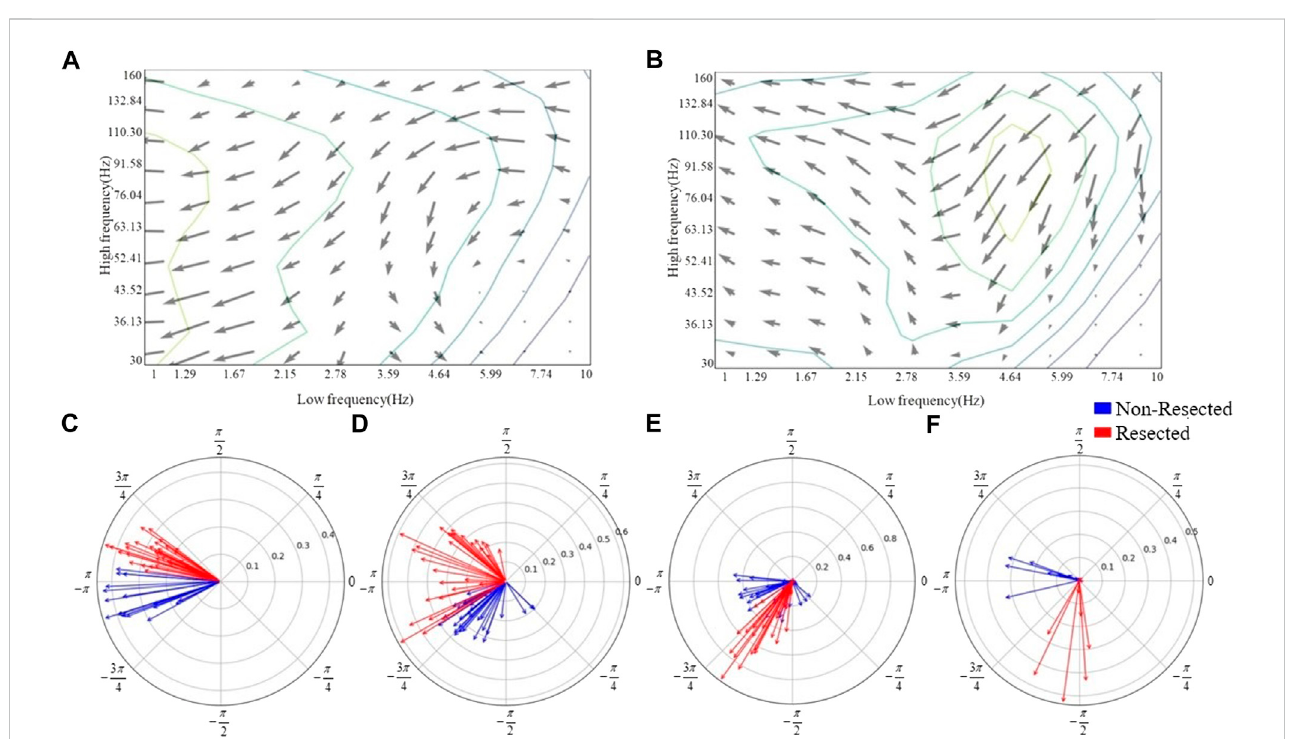
FIGURE 4 Phasedistributionoflow-frequencybands. (A) ThequivermapofaveragedstrengthandphaseofCV-PACsinnon-resectedregions.Notethatthelength and angle of each gray arrow represent the coupling strength and coupled phase at each high- and low-frequency pair, respectively. (B) The quiver map of averaged strength and phase of CV-PACs in resected regions. The length and angle of each arrow represent the coupling strength and coupled phase, respectively. (C) The coupling with phases in slow-delta (1 – 2 Hz). The blue and red arrows indicate the coupling in the non-resected and resected regions, respectively. (D) The coupling with phases in delta (2 – 4 Hz). (E) The coupling with phases in theta (4 – 8 Hz). (F) The coupling with phases in